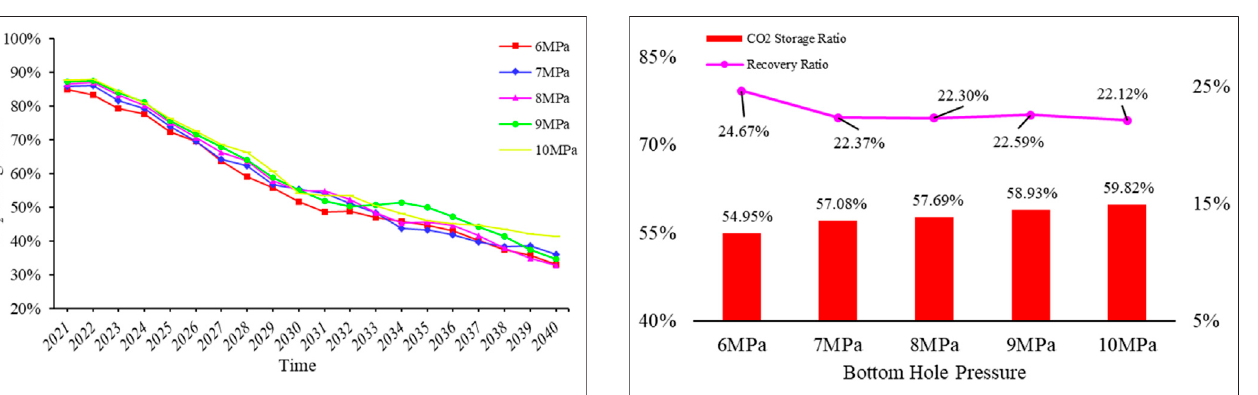
FIGURE 12 | Annual CO 2 storage ratio under different bottom hole pressures.